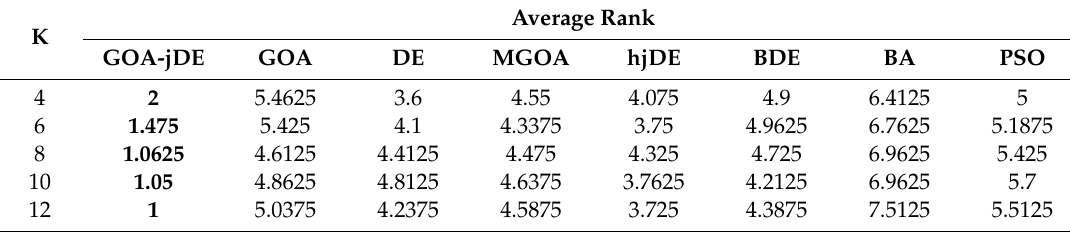
Table 9. The average rank (Friedman test) for the experimental results of the MCE